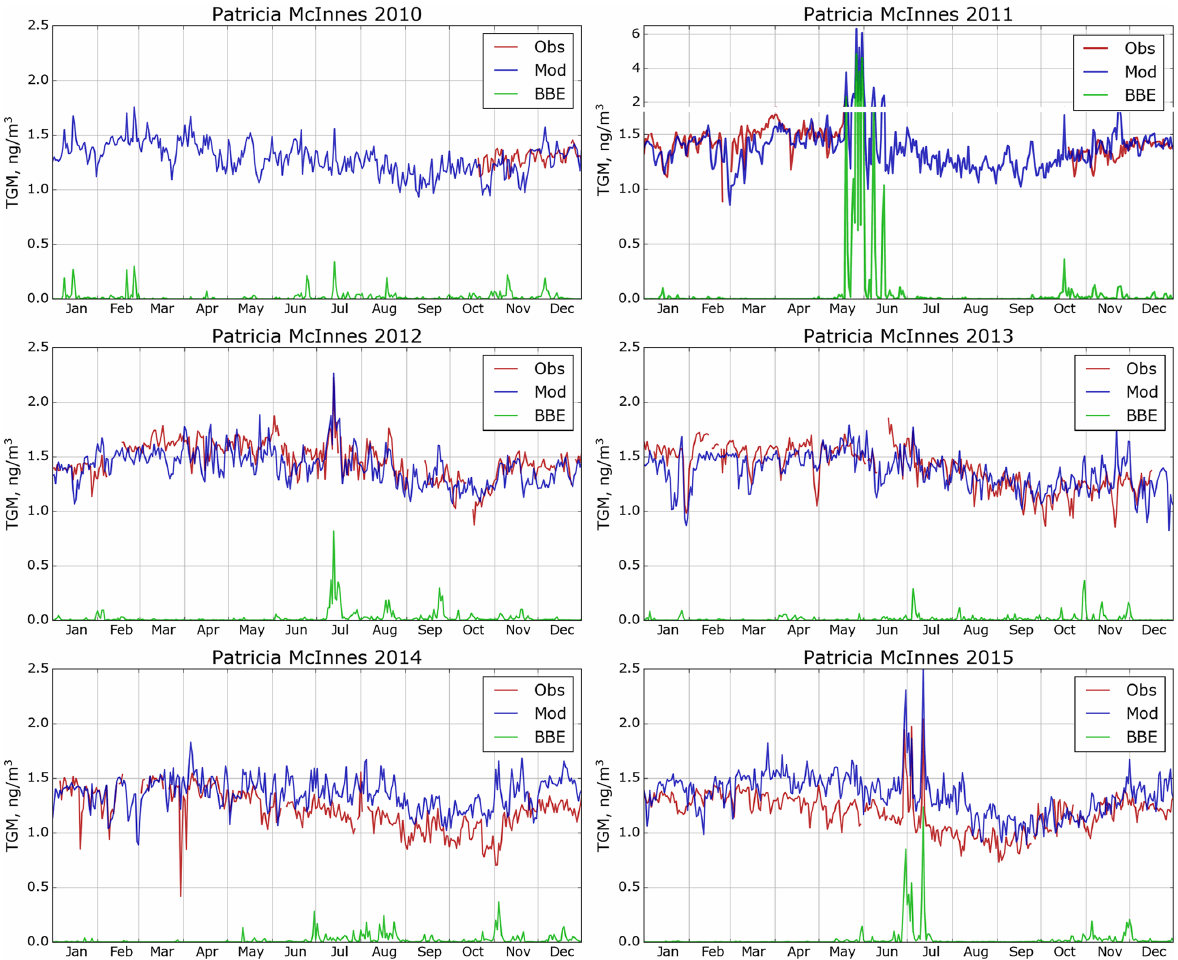
Figure 4. Simulated and observed daily averaged surface air TGM concentrations in AOSR for the site Patricia McInnes (2010–2015). Obs – observations; Mod – model estimation; BBE – modelled biomass burning contributions. Note the larger range of the y axis to plot the strong biomass burning event in May and June of